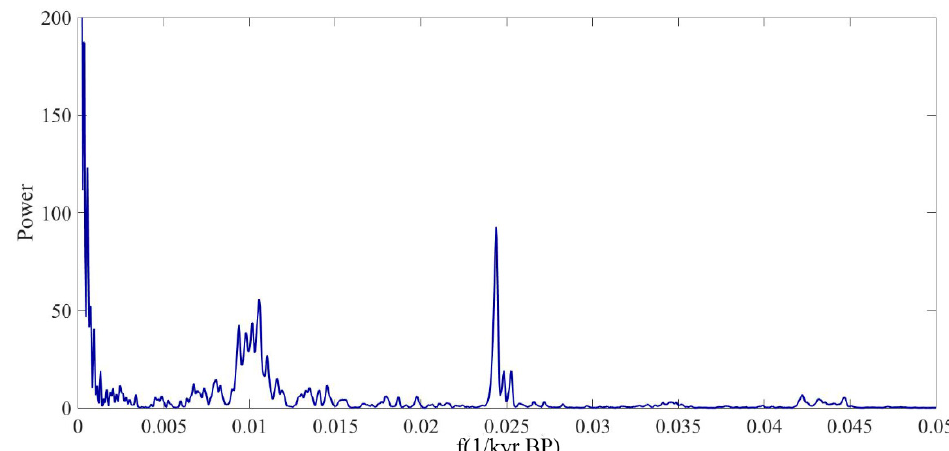
Figure 2. Fourier power spectrum as a function of frequency, expressed in inverse kyears, of the whole not equispaced record. The Lomb–Scargle approach has been employed.